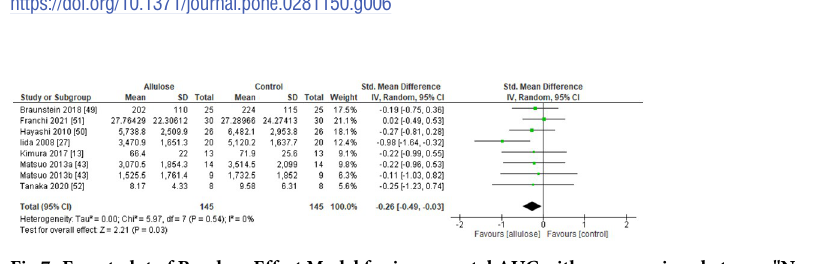
Fig 7. Forest plot of Random Effect Model for incremental AUC with a comparison between "Normal-Intakes ( < = 10g) and control".